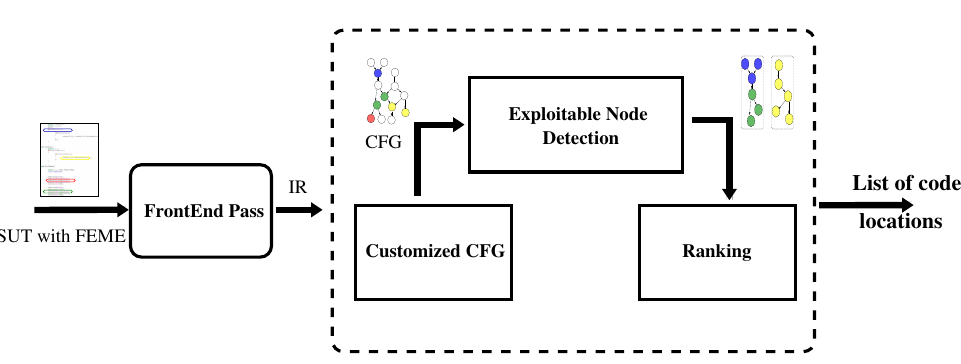
Figure 6: Fault Evaluation in FEDS convert the SUT to CFG, then determine all the exploitable IR instructions from the given